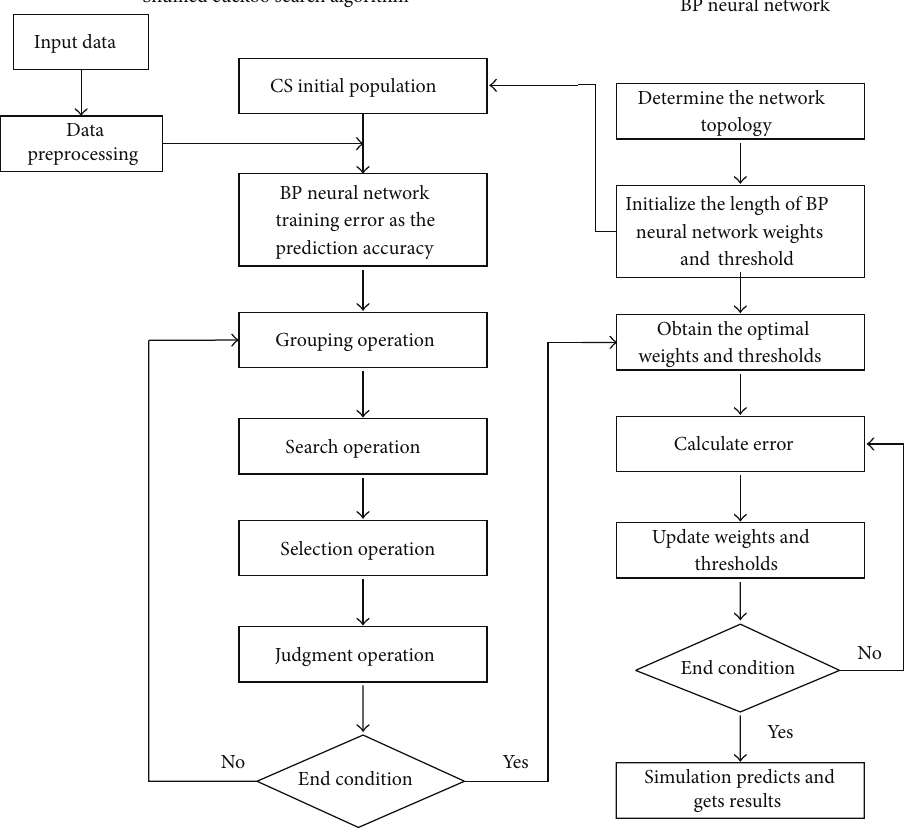
Figure 9: Structure diagram of SCS-BPNN training